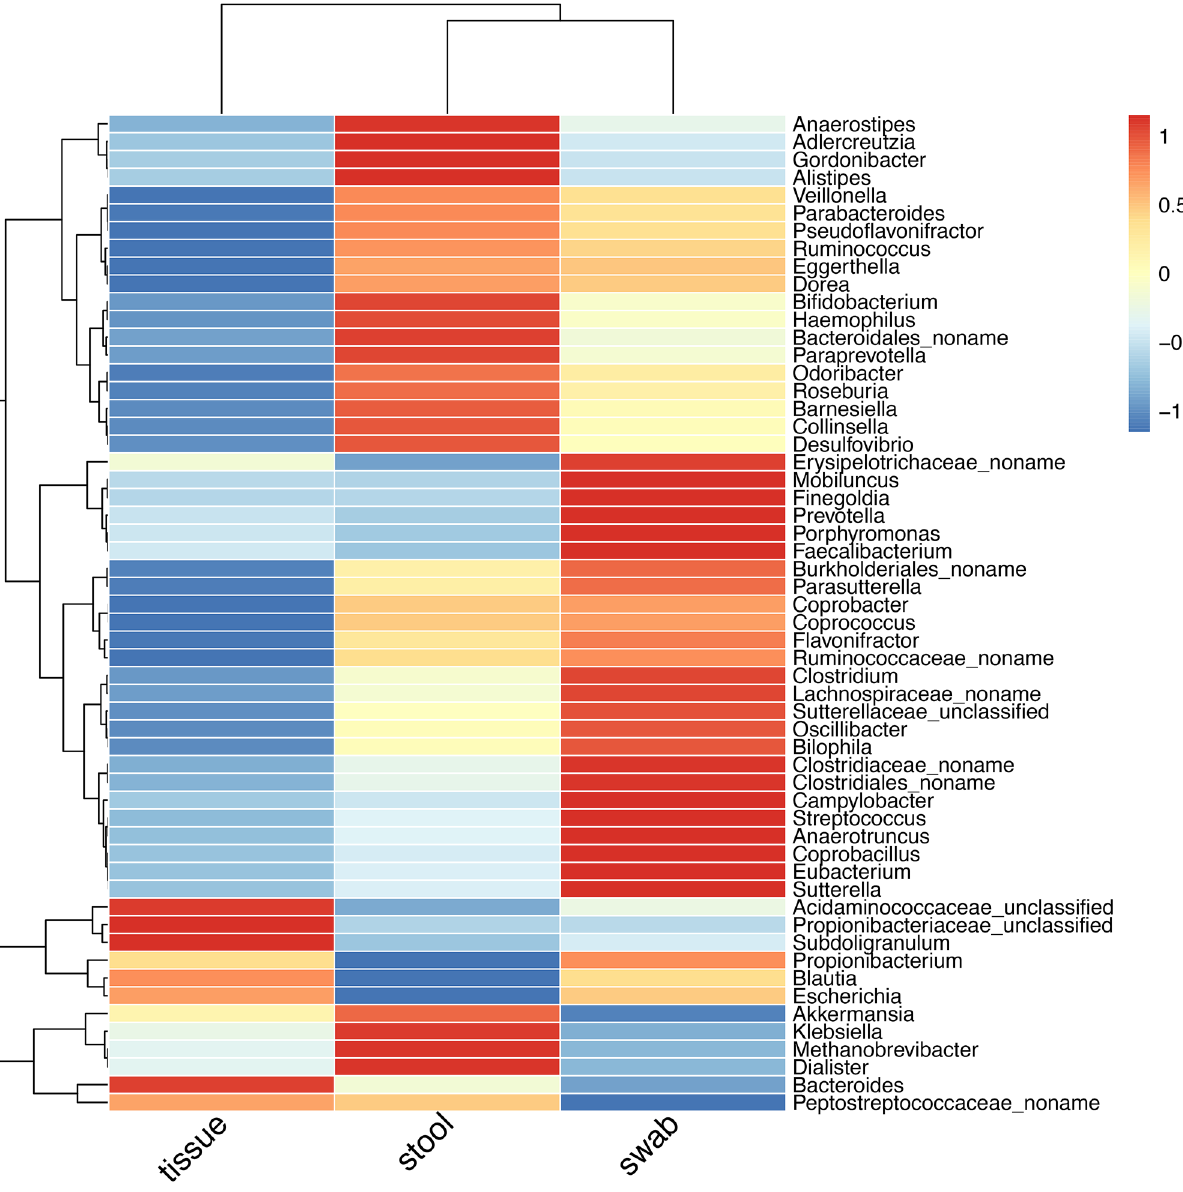
Figure 2. Heatmap of genera that were significantly different between sample types (FDR < 0.05). Keys indicate the z-scores of averaged taxonomic